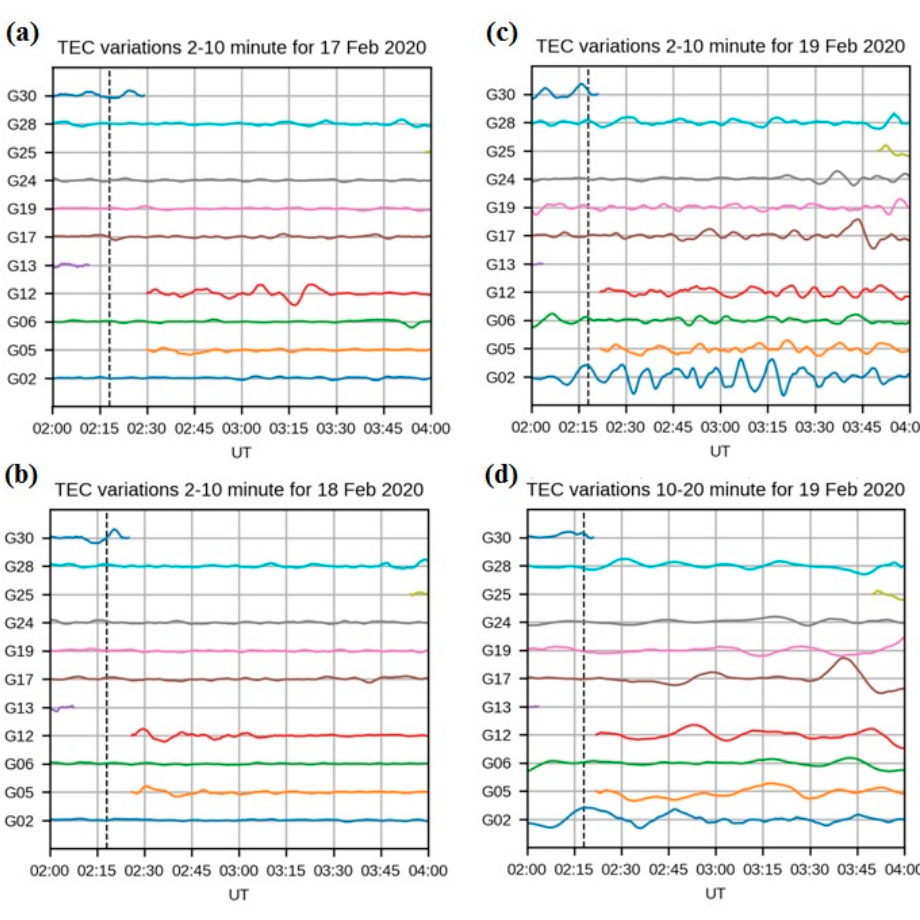
Figure 12. (2–10) min dIv series in different LoSs to UCOE receiver during: ( a ) the quiet day, ( b ) geomagnetic disturbance day and ( c ) day of meteoroid. ( d ) The same as in panel “ c ” but for the (10–20) min dIv series. Each curve represents dIv for the corresponding satellite. The Y -axis unit is 0.1 TECU. The dashed line marks the explosion moment.